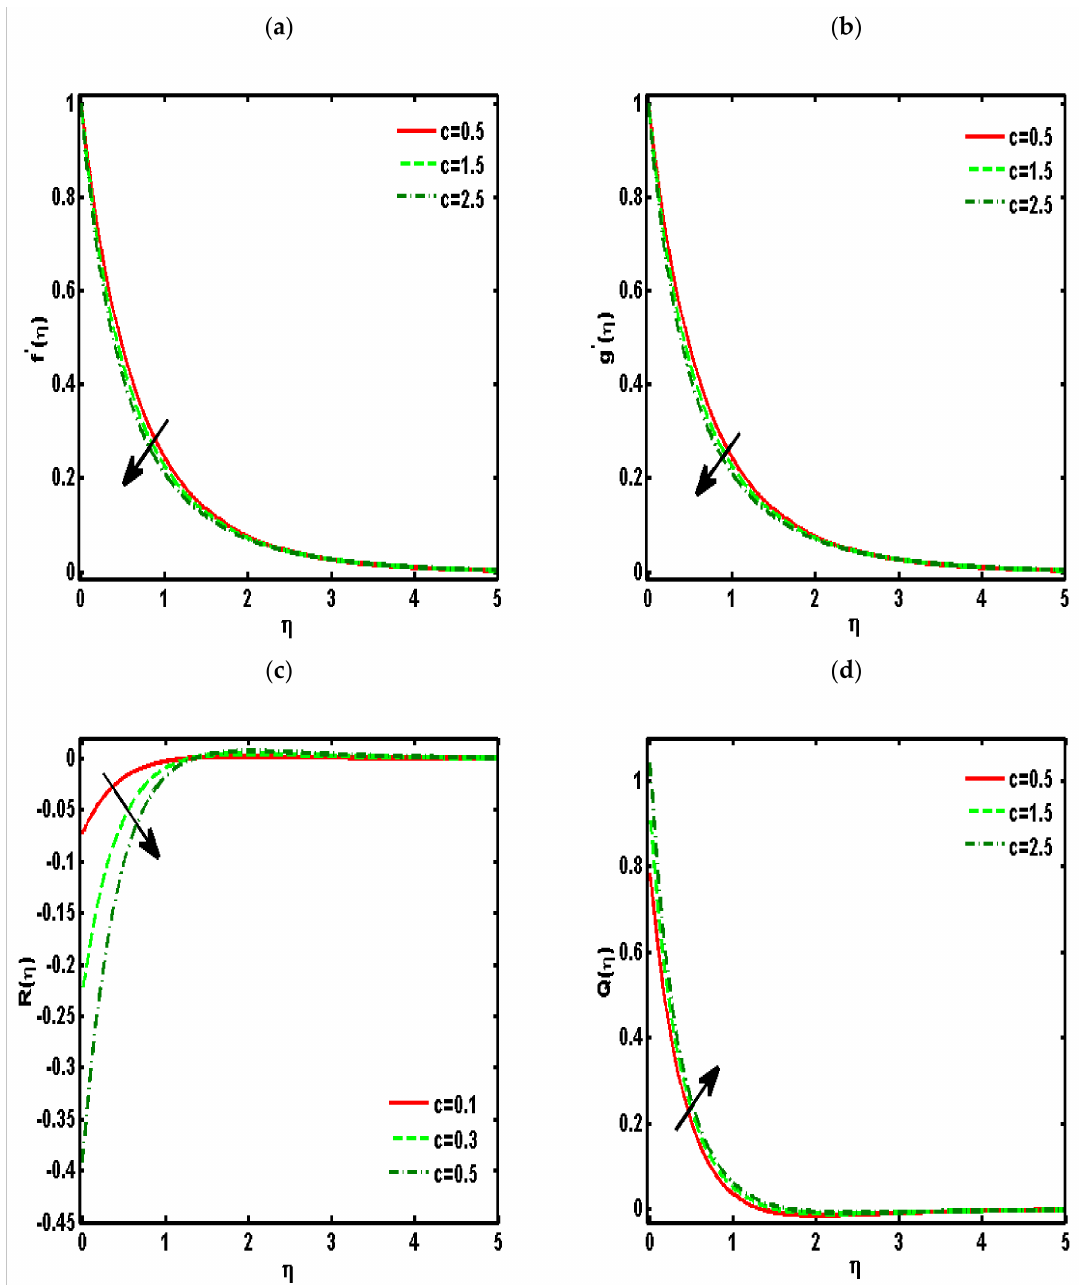
Figure 4. Effects of the stretching ratio parameter ( c ) on ( a ) f (cid:48) ( η ) , ( b ) g (cid:48) ( η ) , ( c ) R ( η ) , ( d ) Q ( η ) . ( φ 2 = 0.01, Pr = 6.2, K = 0.5, a =